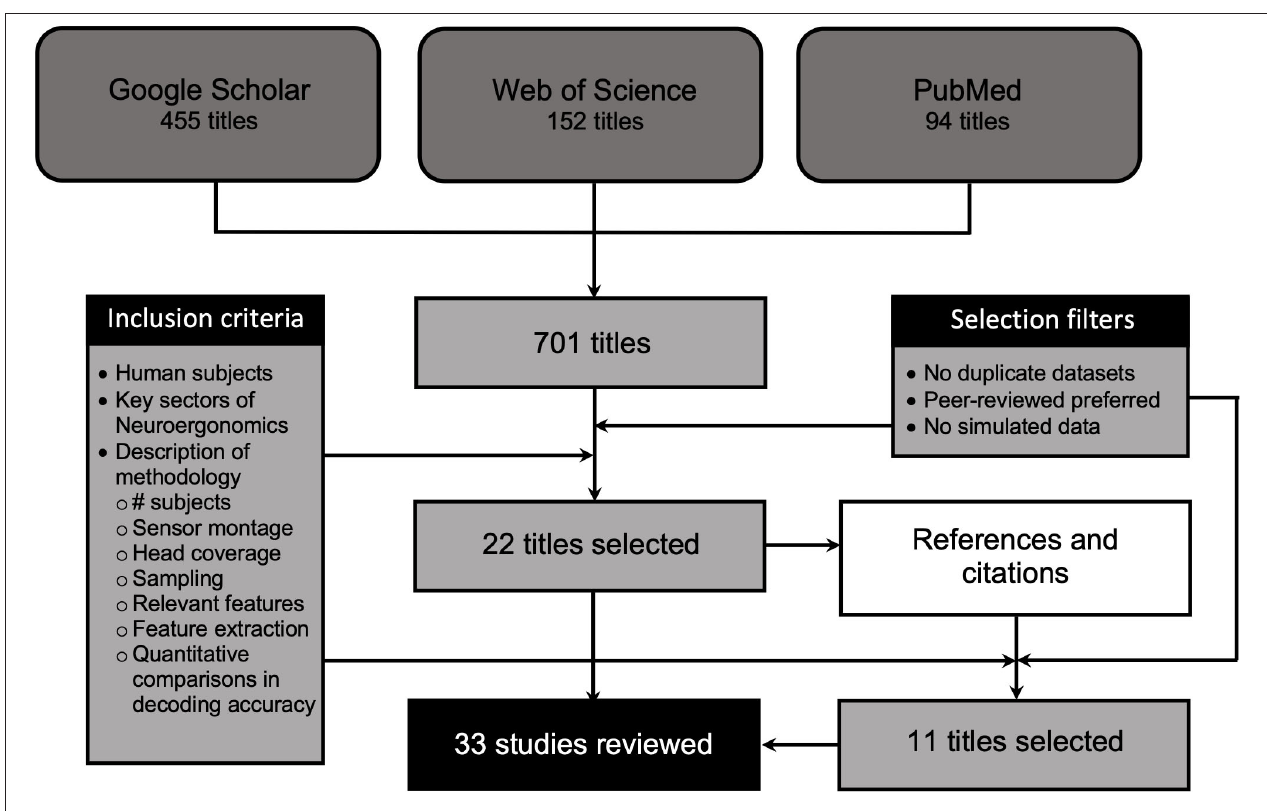
FIGURE 1 | Flowchart of the literature